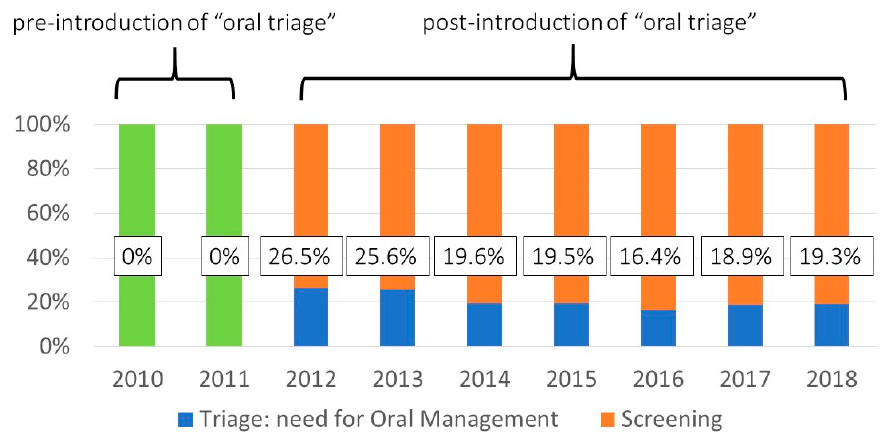
Figure 4. Changes in the number of ‘triage’ patients. The graph shows the yearly trend in the percentage of patients who underwent oral screening and required oral management. The percentage was ‘zero’ before the introduction of the “oral triage” system. The green bars show all surgical patients when no screening was performed.